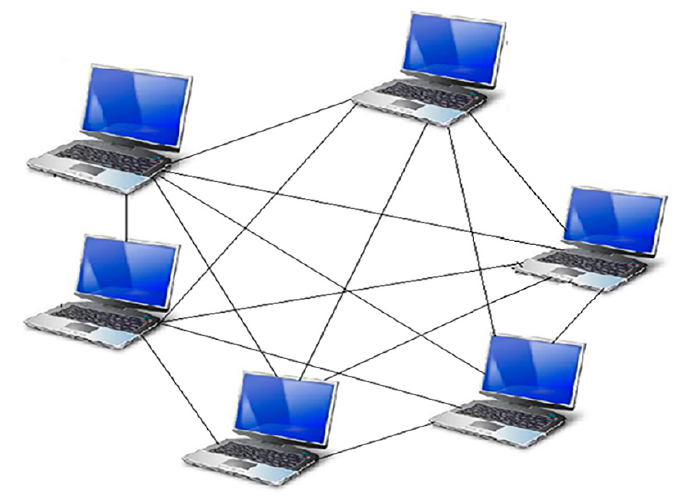
Figure 2. network site of fully-connected architecture. Figure 2. Network site of fully-connected